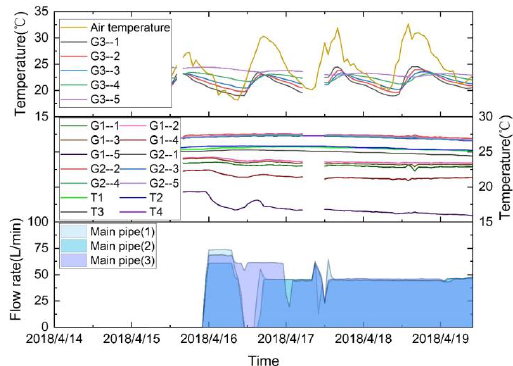
Figure 4. Data regarding all the thermometers and main pipes.